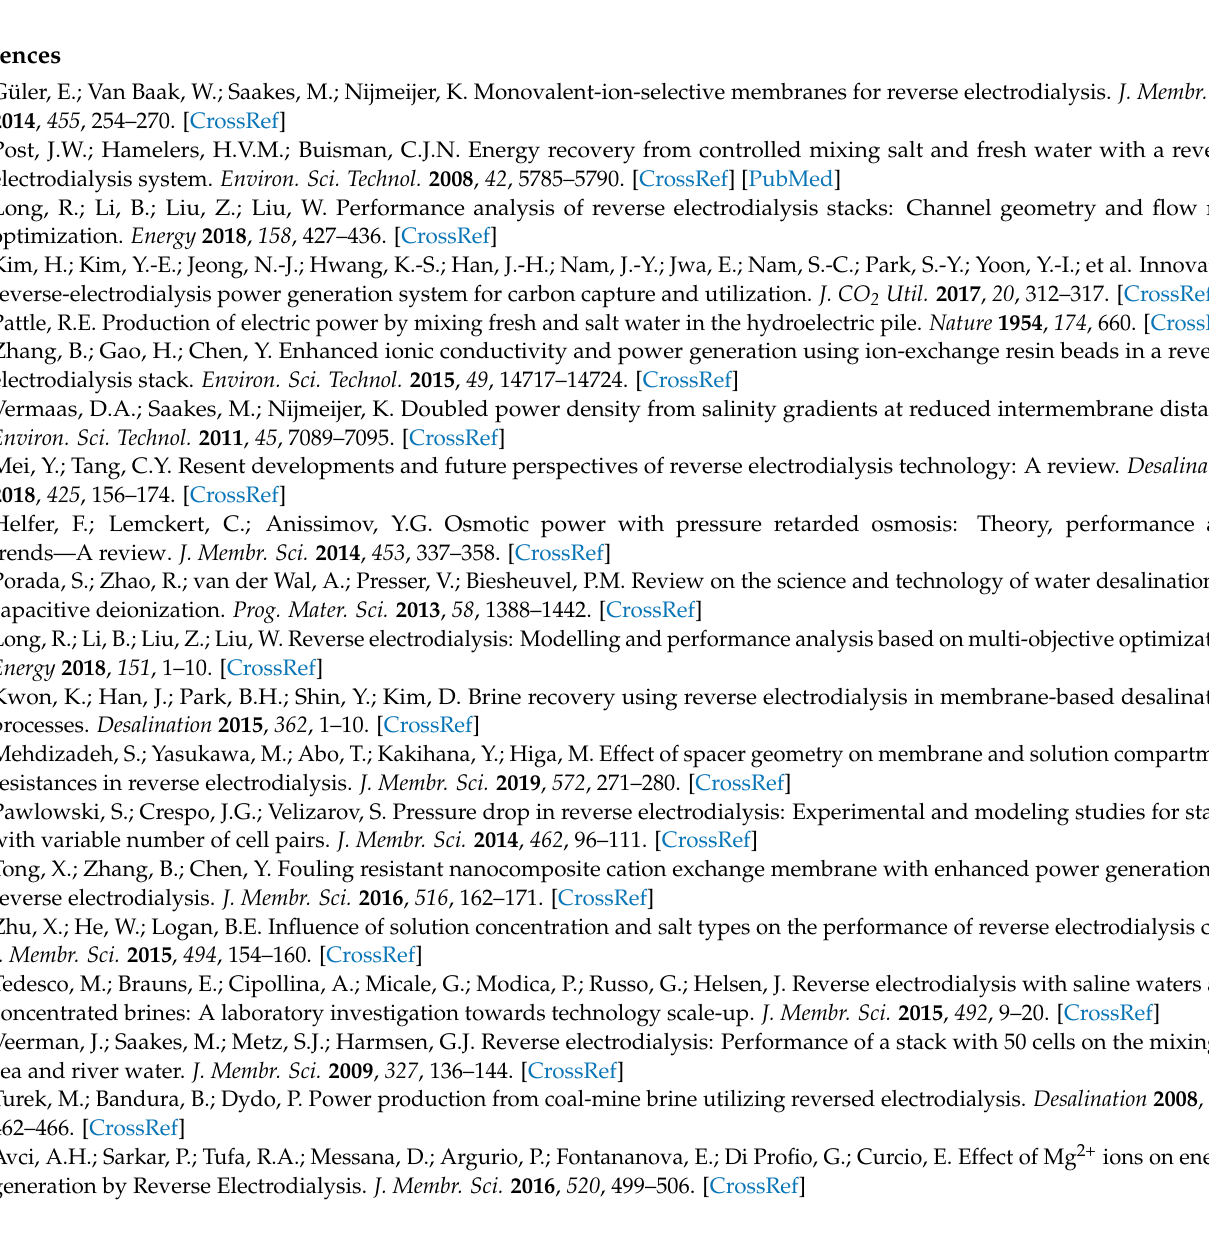
Figure A12. The RED stack pressure drops as a function of the feed flow rate using the model